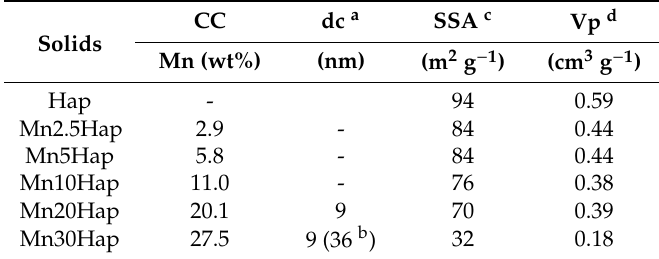
Table 1. Chemical composition (CC) and textural properties of the calcined solids. CC dc a SSA c Vp d Solids Mn (wt%) (nm) (m 2 g − 1 ) (cm 3 g − 1 ) Hap - 94 0.59 Mn2.5Hap 2.9 - 84 0.44 Mn5Hap 5.8